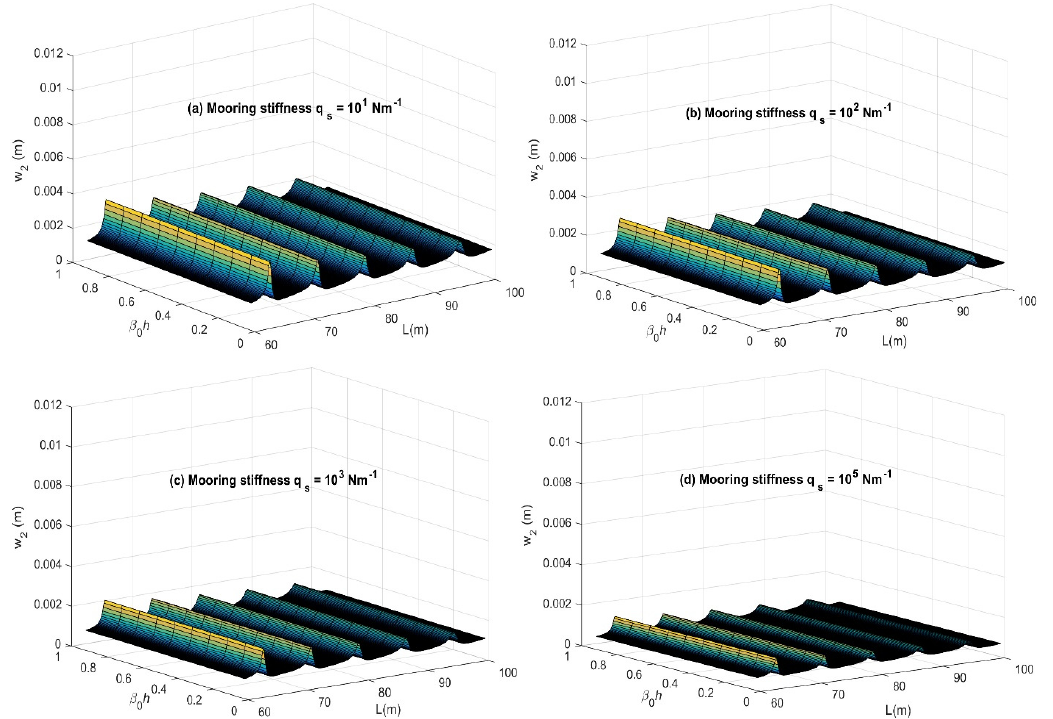
Figure 11. Influence of the mooring stiffnesses on the submerged flexible porous plate displacement for θ = 60 o and σ = 0.5 i .